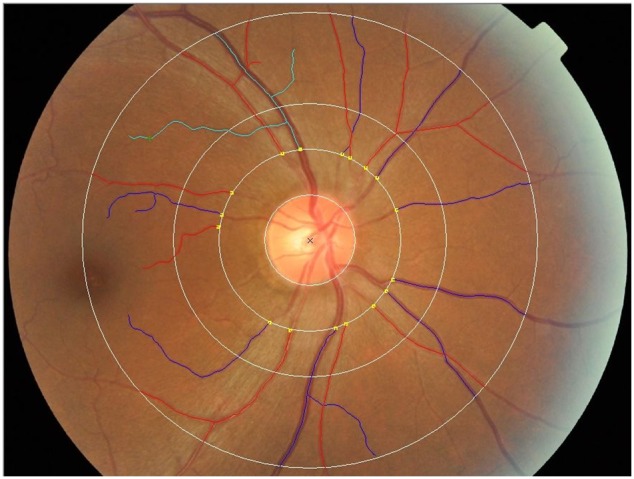
Fundus photographs processed by SIVA version 3.0 software.Test zone was 0.5- to 2.0-disc diameters away from the optic disc margin. A red line represents an artery and a blue line represents a vein. Fractal dimension, D(f), is a complexity indicator determined by reactive vessels obtained from vascular tracking through the box counting dimension method.